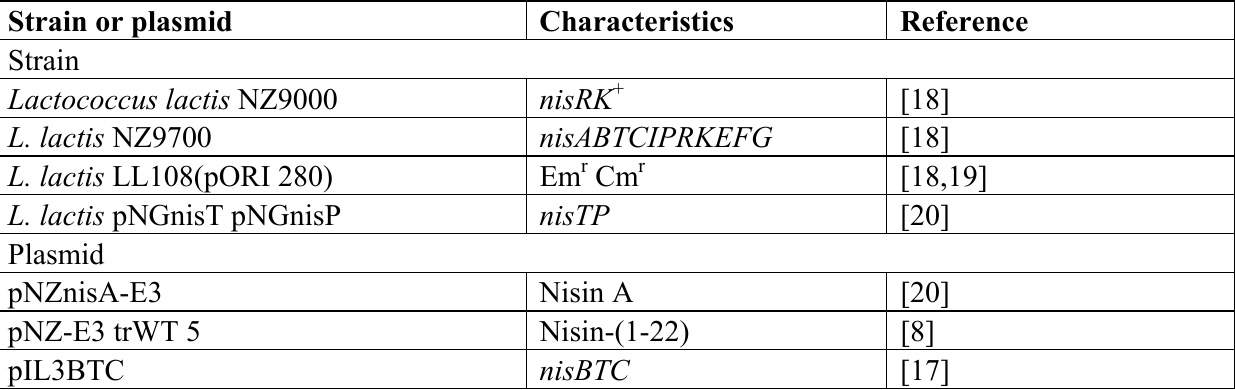
Table 1. Bacterial strains and